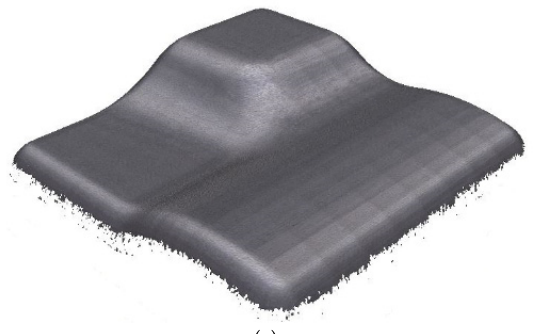
Figure 9. An example of the result of the scanned surface of a single sample on a Alicona Infinite Focus G5 ( a ) 3 + 2 mill- ing, tool axis inclinations β f = 5°, β n = 10°, ( b ) red square area (4 mm × 4 mm) for surface roughness measurement.